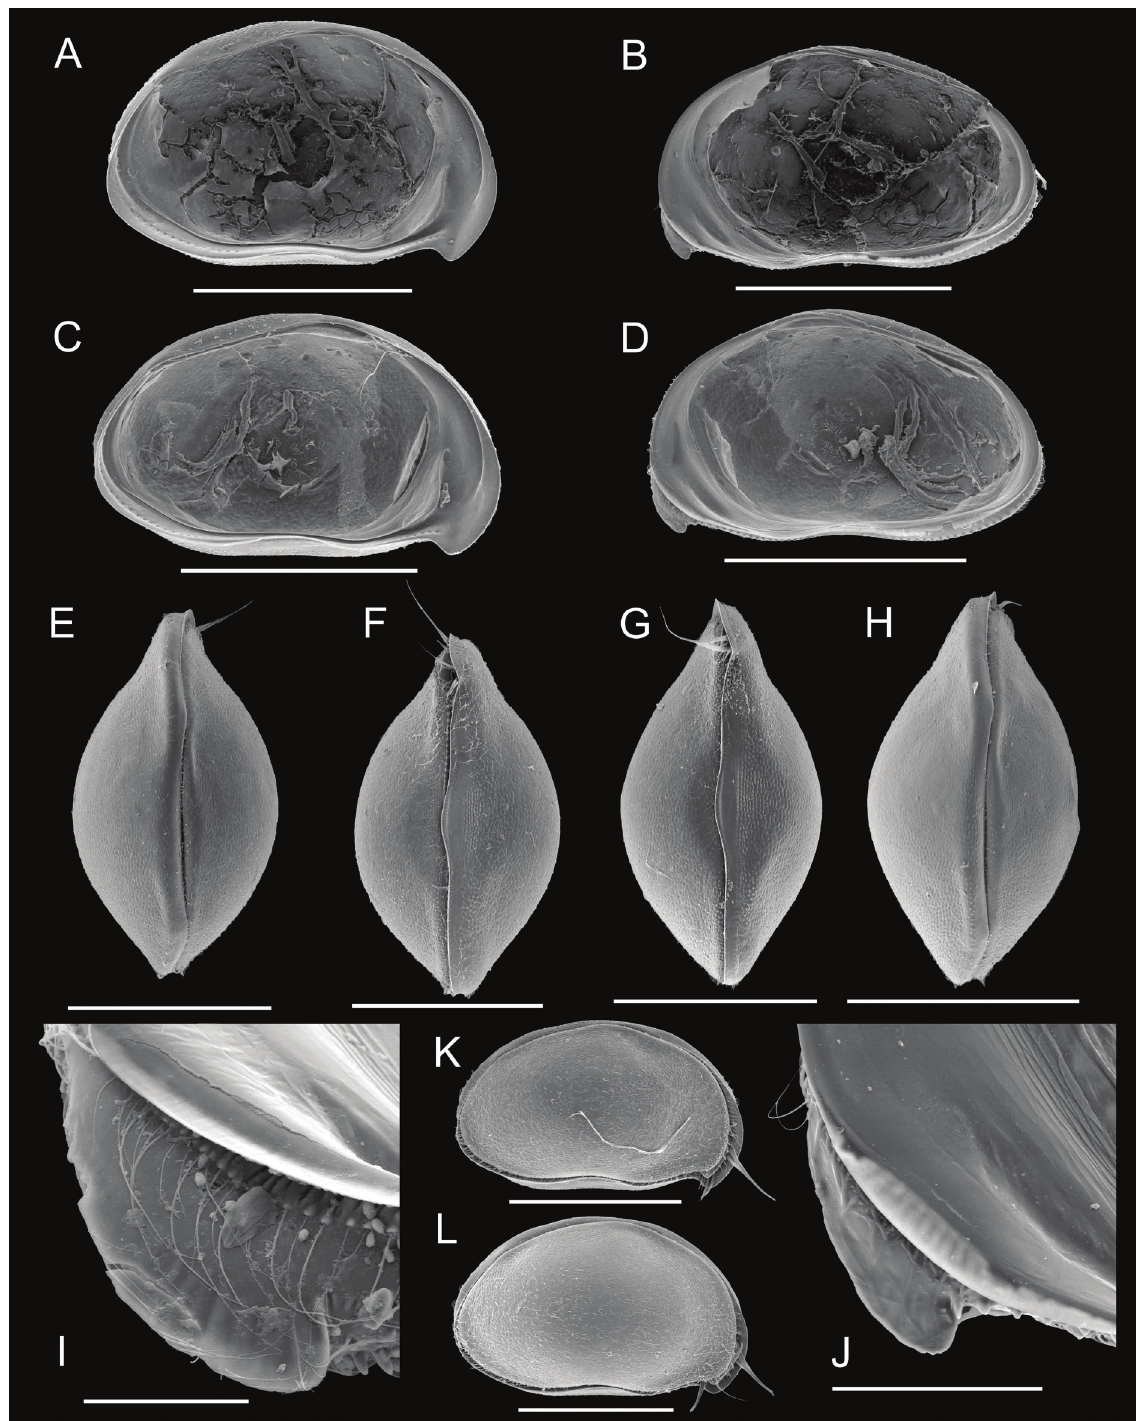
Fig. 12. Bennelongia coondinerensis sp. nov., all from Coondiner Pool (Type locality). A . LVi (allotype ♀, WAM.C49390). B . RVi (♀, Idem). C . LVi (holotype ♂, WAM.C49389). D. RVi (♂, Idem). E . Cp dorsal (♀, WAM.C49391C). F . Cp ventral (♀, WAM.C49391B). G . Cp ventral (♂, WAM.C49392B). H . Cp dorsal (♂, WAM.C49392A). I . RVi (detail anteriorly, holotype ♂, WAM.C49389). J . rVi (detail anteriorly, allotype ♀, WAM.C49390). K . CpRe (♂, WAM.C49391A). L . CpRe (♀, WAM.C49391C). Scales: A-H, K-L = 1000 µm; J = 200 µm; I = 100